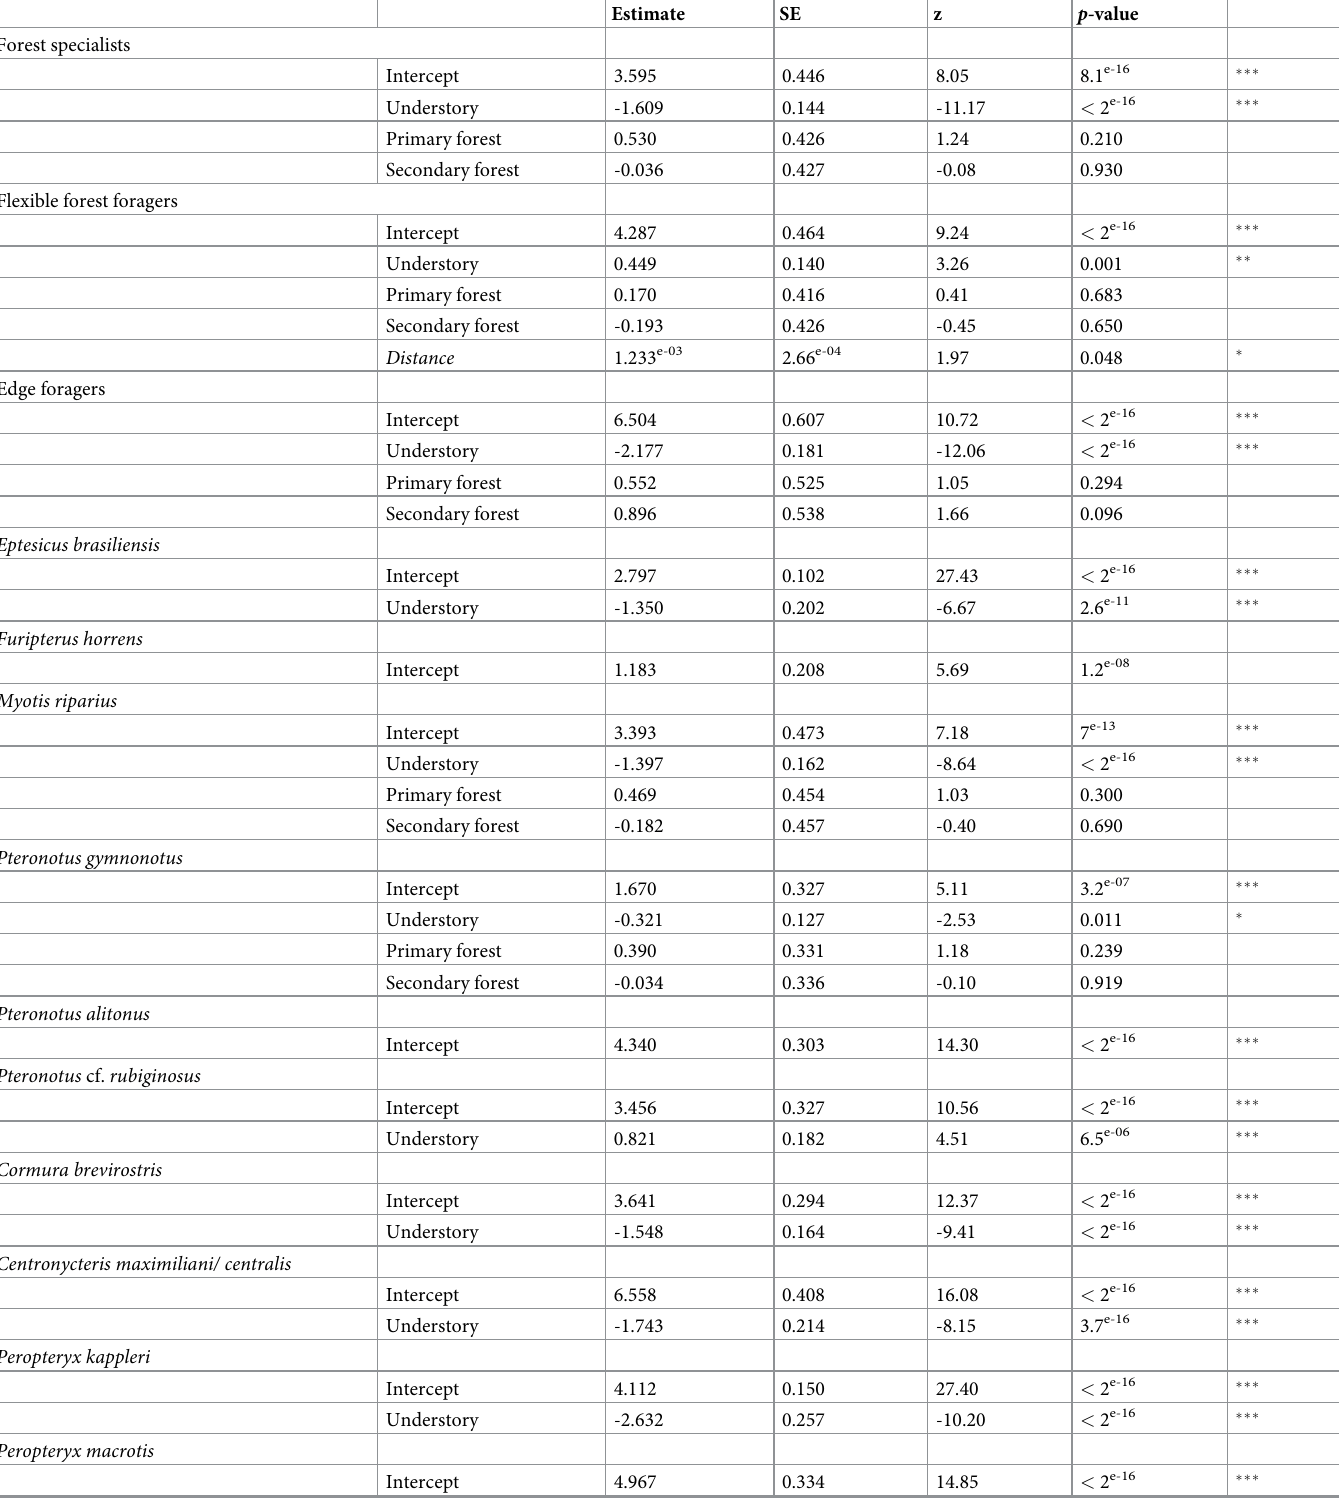
Table 3. Summary of the best-fit generalized linear mixed effect models for each bat guild and